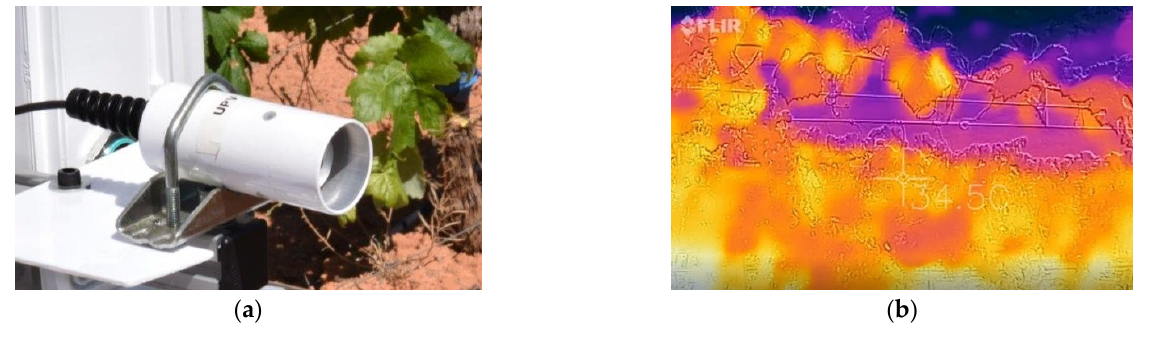
Figure 6. Non-invasive monitoring of canopy temperature: ( a ) infrared radiometer (Apogee Instruments, Inc., Logan, UT, USA); and ( b ) thermographic images of a vineyard from a terrestrial vehicle (FLIR Systems, Inc., Wilsonville, OR, USA).